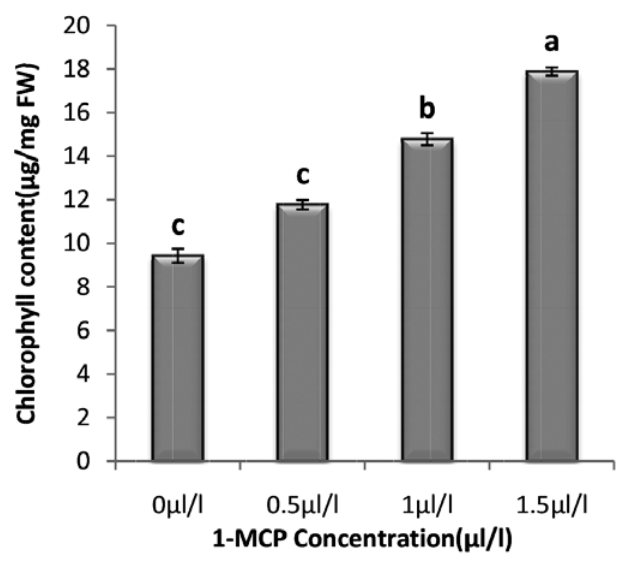
Fig. 3 - Effect of 1-MCP on petal chlorophyll content of carnation cv. Fortune. Data are means with standard errors (n=3).